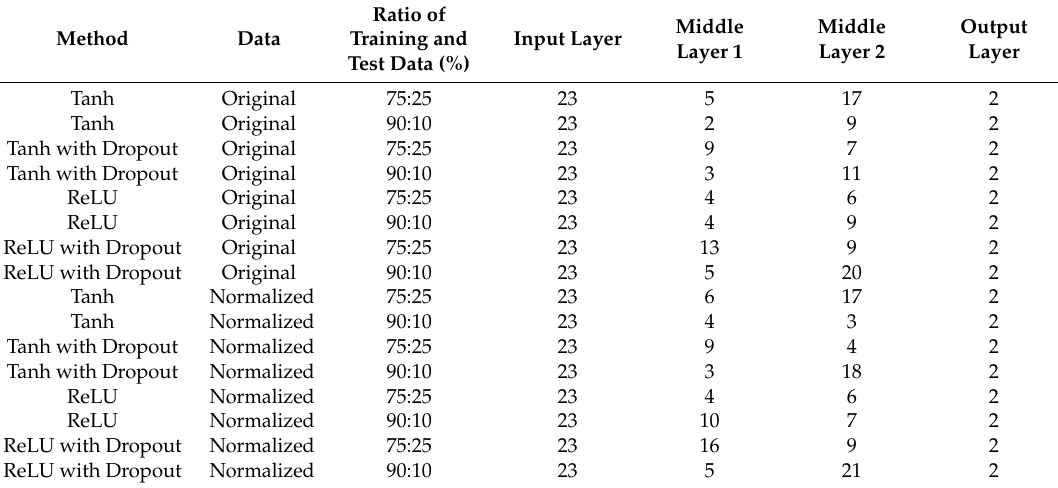
Table A2. Number of units in middle layers for